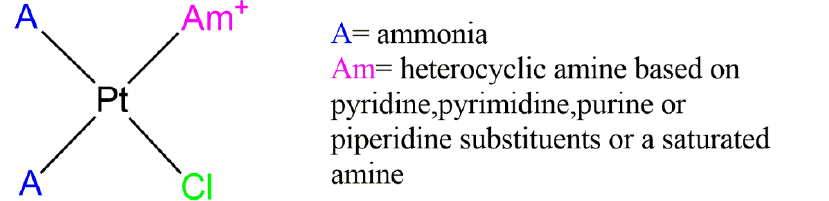
Figure 4. Chemical structure of cationic triamine complexes. A = ammonia; Am = heterocyclic amine based on pyridine, pyrimidine, purine, piperidine, or saturated amine. In detail, cis -[Pt(NH 3 ) 2 ( N3 -cytosine)Cl]Cl and cis -[Pt(NH 3 ) 2 ( N7 -2 (cid:48) -deoxyguanosine)Cl]Cl complexes showed the best combination of activity and potency in the S180a screen. In the L1210 leukemia screen, cis -[Pt(NH 3 ) 2 ( N3 -cytosine)Cl]Cl and cis -[Pt(NH 3 ) 2 ( N3 -cytosine)Cl]Cl demonstrated good antitumor activity. Cis -[Pt(NH 3 ) 2 ( N3 -cytosine)Cl]Cl was also found active against P388